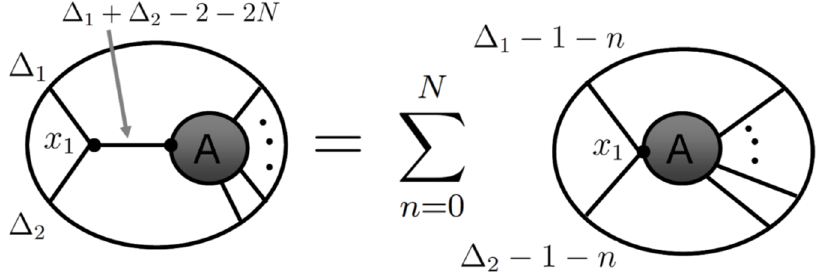
Figure 5 . Identity 3’. This identity generalizes the well known relations between tree level exchange 4-point diagrams and 4-point contact diagrams. We are suppressing numerical coe(cid:14)cients in these plots. The grey blob is general, and the diagrams correspond to stripped correlators.